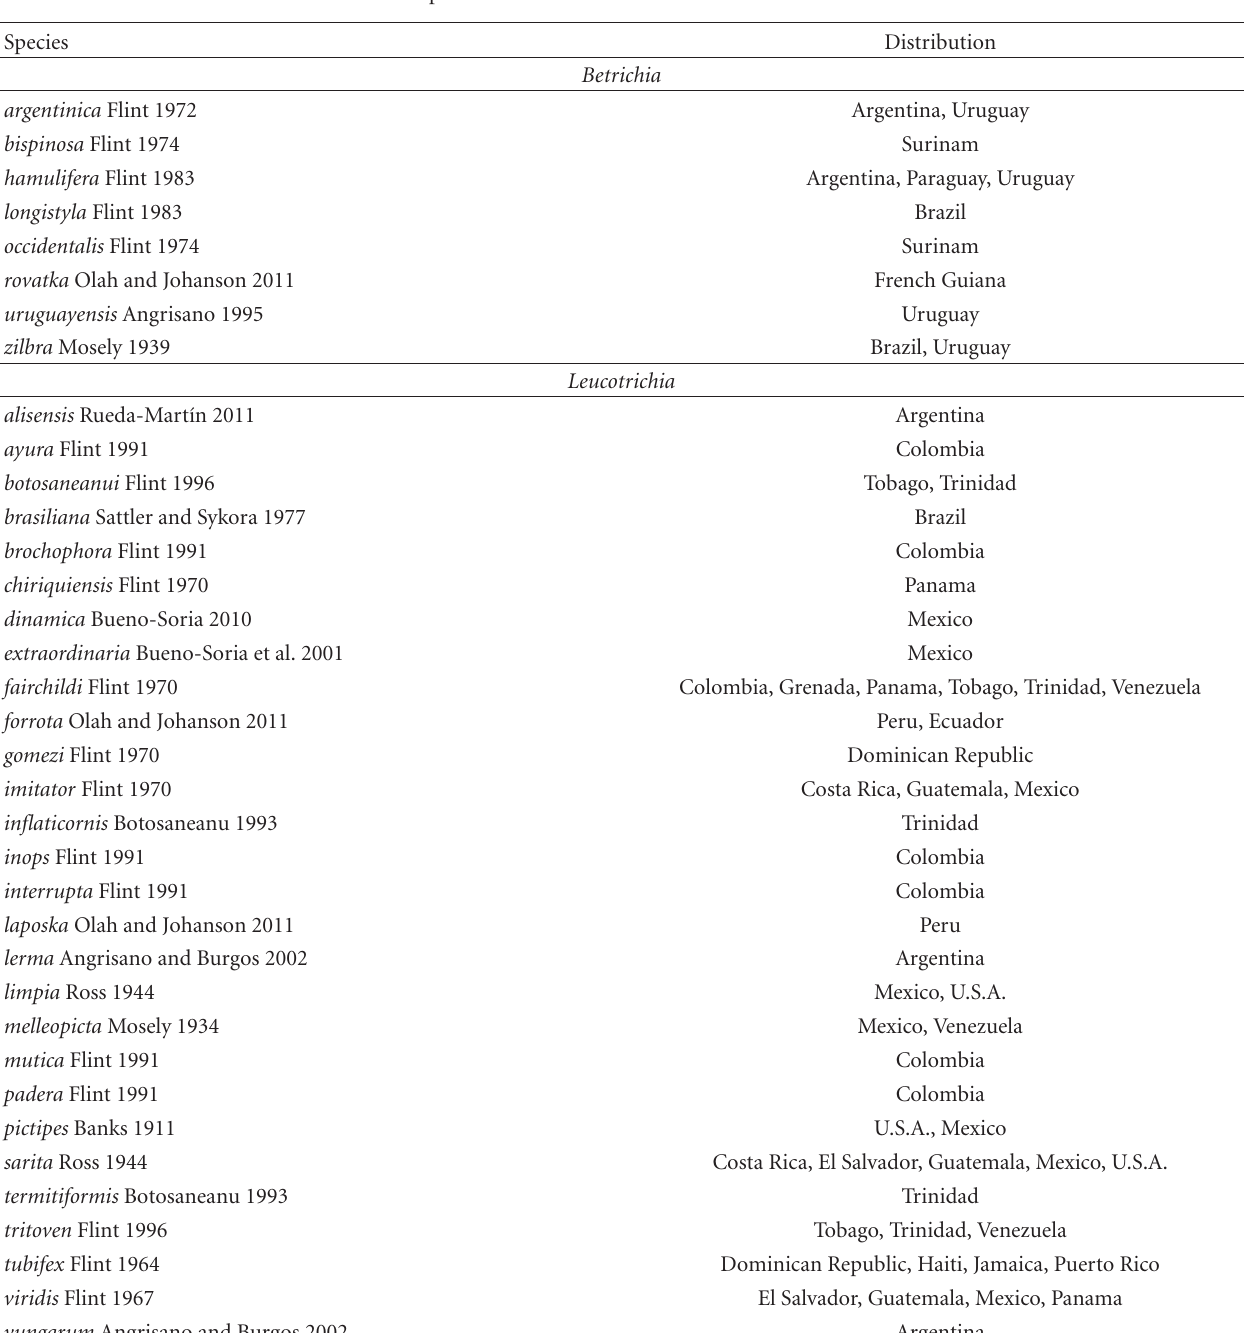
Table 1: Species and distributions of Betrichia and Leucotrichia